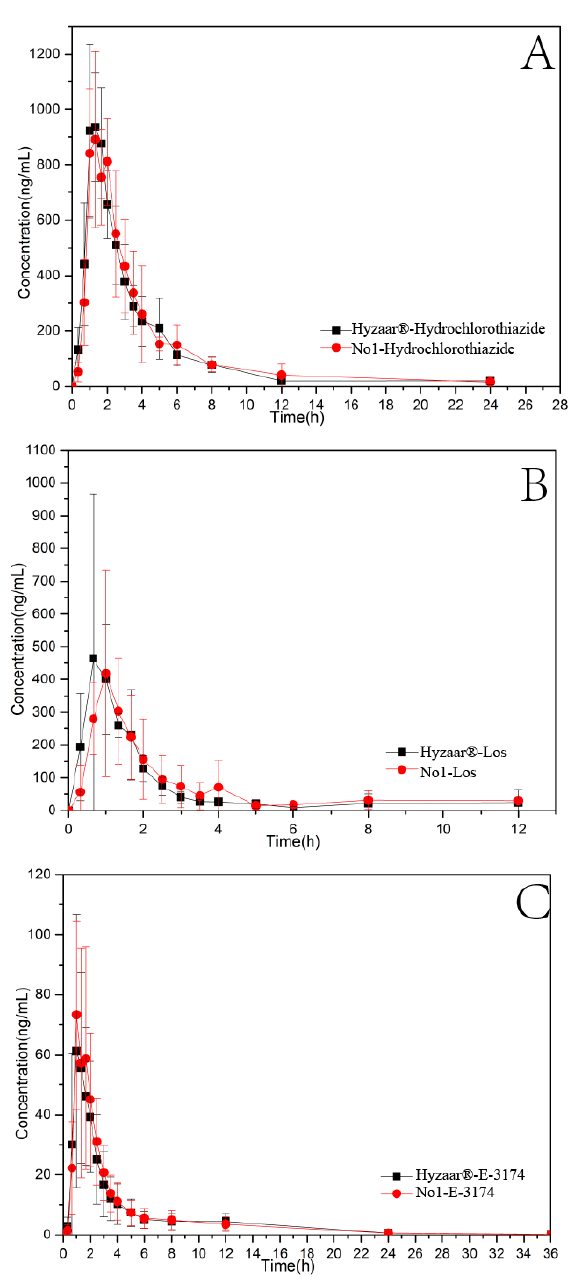
Figure 10. Mean plasma-concentration time profiles of HCTZ ( A ), LOS-K ( B ), and E-3174 ( C ) after oral administration.